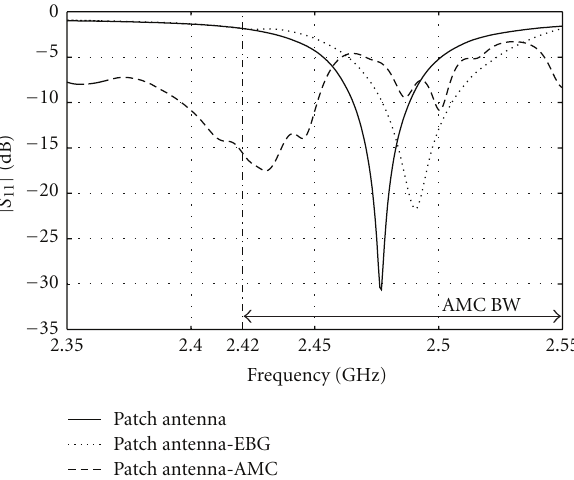
Figure 5: Patch antenna-AMC prototype layout.